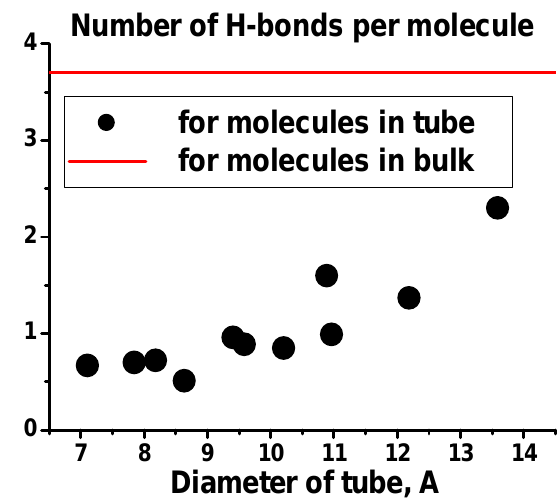
Figure 7. Dependencies of amount of H-bonds on the CN